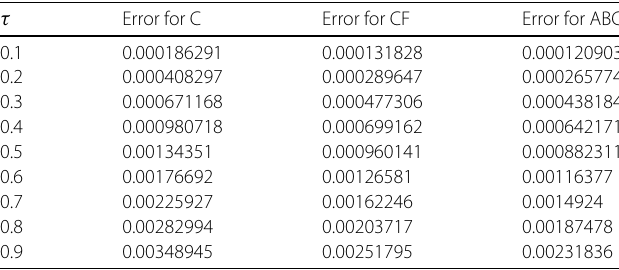
Table 2 AREs of y ( τ ) obtained by fourth-order OPIA solutions using different fractional operators at β = 0.9